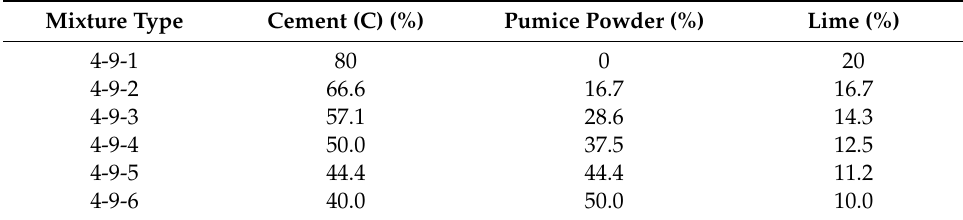
Table 15. Type 4-9 mixing